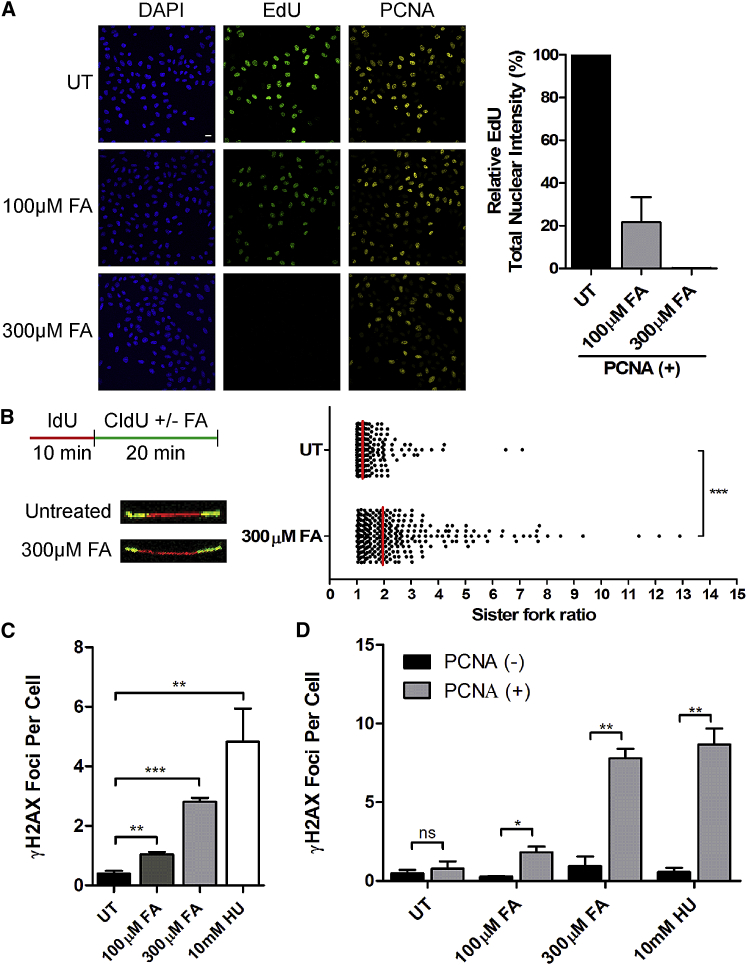
Formaldehyde Stalls DNA Replication and Induces Strand Breakage in Dividing Cells(A) Immunofluorescence images of HeLa Kyoto cells labeled with EdU (1 hr) after 2 hr formaldehyde (FA) treatment. UT, untreated. Scale bars, 20 μm. The histogram quantifies the mean ± SEM of total EdU nuclear intensities, n = 3.(B) DNA fiber analysis comparing sister fork symmetry. The experimental setup and representative images are shown. The scatterplot compares the ratio of sister-fork tract lengths (see the STAR Methods) between untreated (UT) and FA-treated conditions. Red lines represent the median, n = 3. Statistical significance was determined by the Mann-Whitney t test, n = 3.(C) Mean ± SEM of γH2AX foci per cell 3 hr after indicated treatments. Greater than or equal to 1,500 cells were analyzed per condition. Statistical significance was determined by the two-tailed Student’s t test, n = 4.(D) Mean ± SEM of γH2AX foci per cell in PCNA+ versus PCNA− cells after 3-hr exposure to FA or HU. Statistical significance was determined by the two-tailed Student’s t test, n = 3.